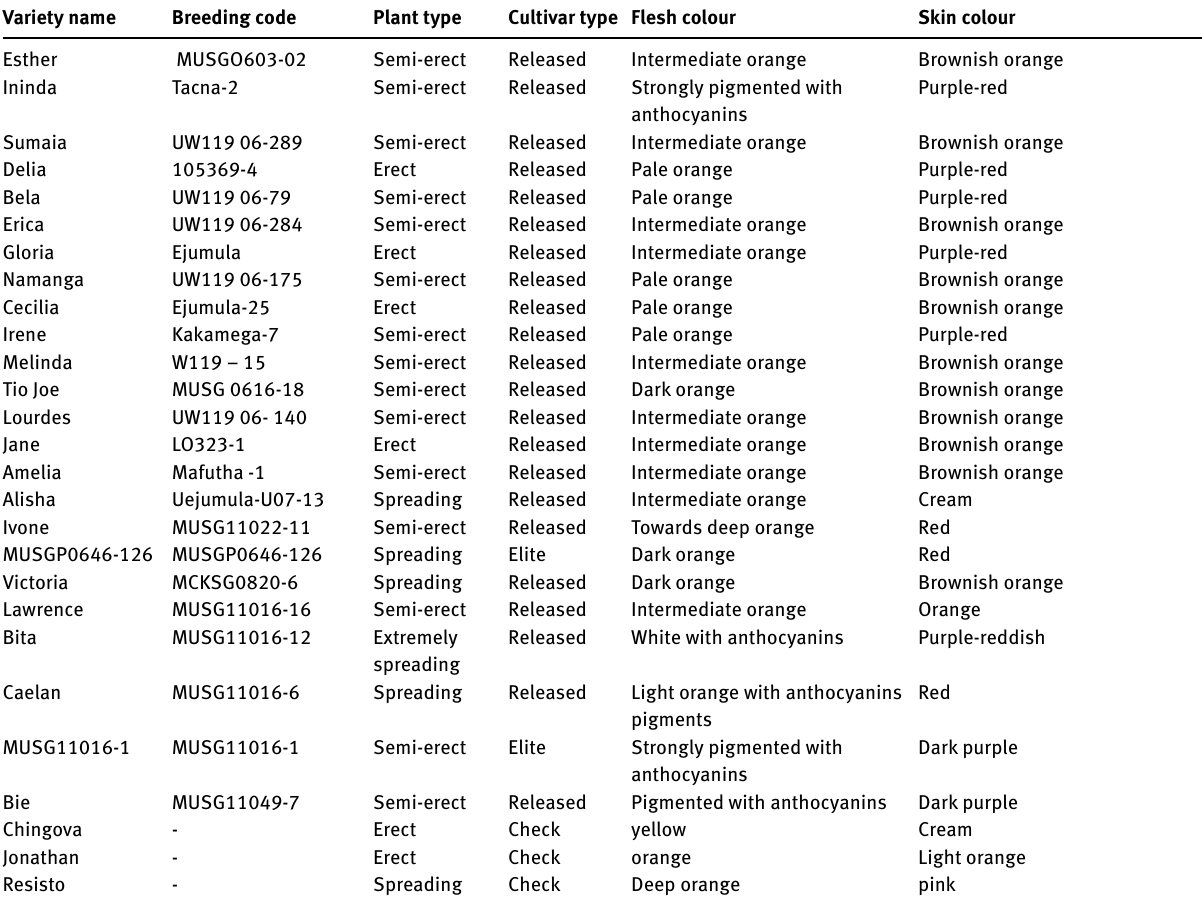
Table 1: List of sweetpotato varieties evaluated for planting to maturity interval and nutritional changes over different harvest dates after